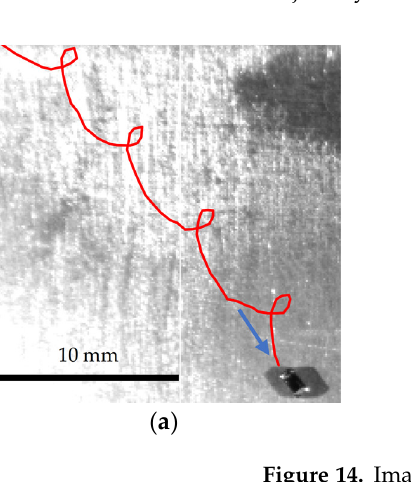
Figure 14. Images captured during the experiments: ( a ) captured trajectory of a single 0603-type MLCC when R = 0.49 mm, ω = 62.83 rad/s, ϕ = 9 π /5, λ = 43 π /90; ( b ) two frames separated by a time interval of 0.792 s that were captured during the manipulation of multiple 0603-type MLCC when R = 0.49 mm, ω = 62.83 rad/s, ϕ = 9 π /10, λ = 43 π /45.